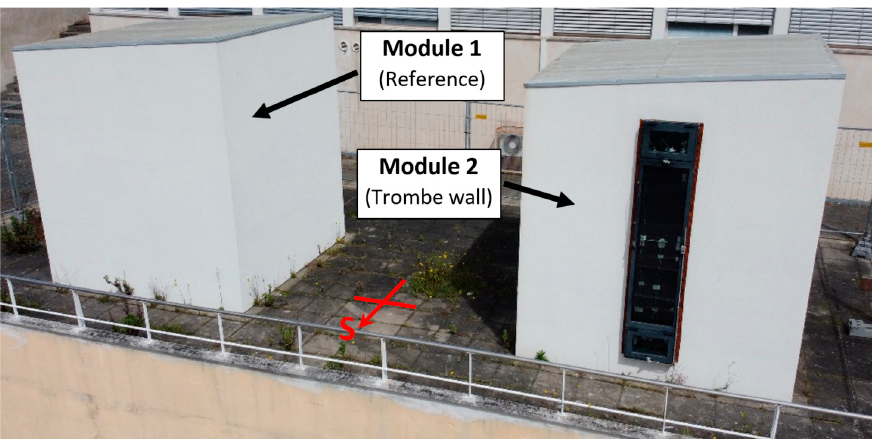
Figure 1. LSF (lightweight steel frame) experimental modules constructed at the University of Coimbra, Engineering Campus (GPS: 40.1855 ° N, 8.4167 ° W).